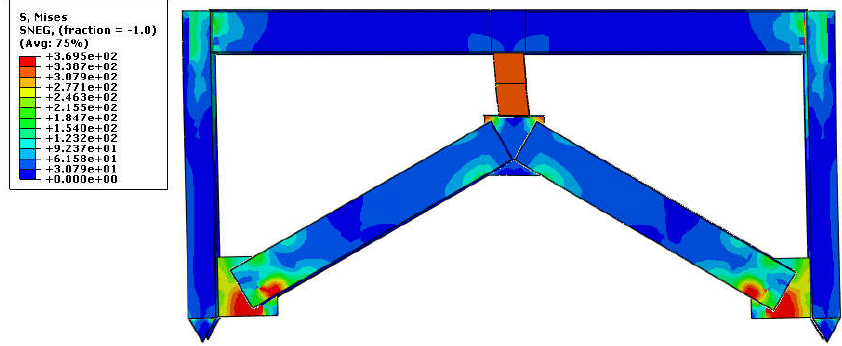
Figure 17. The stresses in the eccentrical braced frame (kN/mm 2 ).